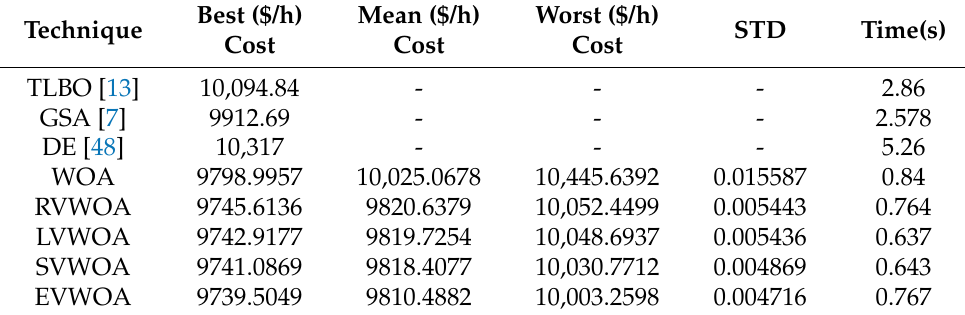
Table 9. Comparison of quality solution for Case Study 3.